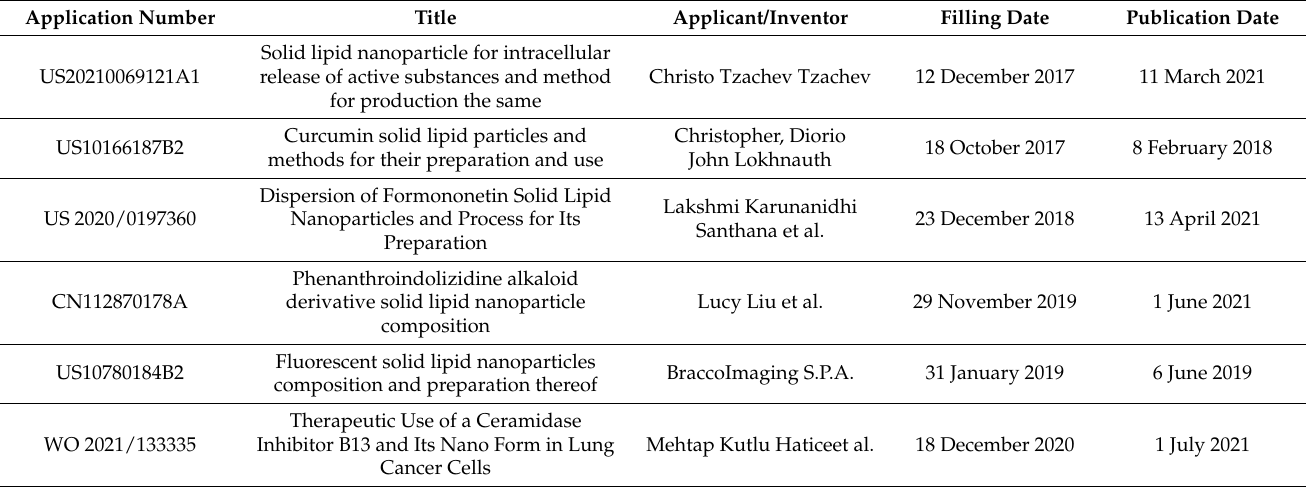
Table 2. Current patents on